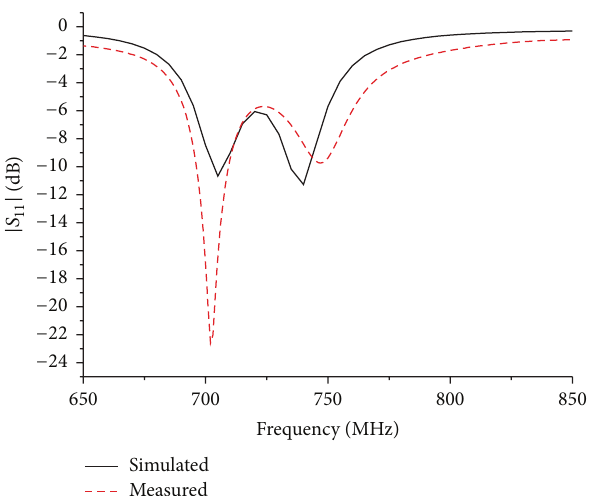
Figure 8: Simulated and measured |𝑆 11 | of the proposed antenna.